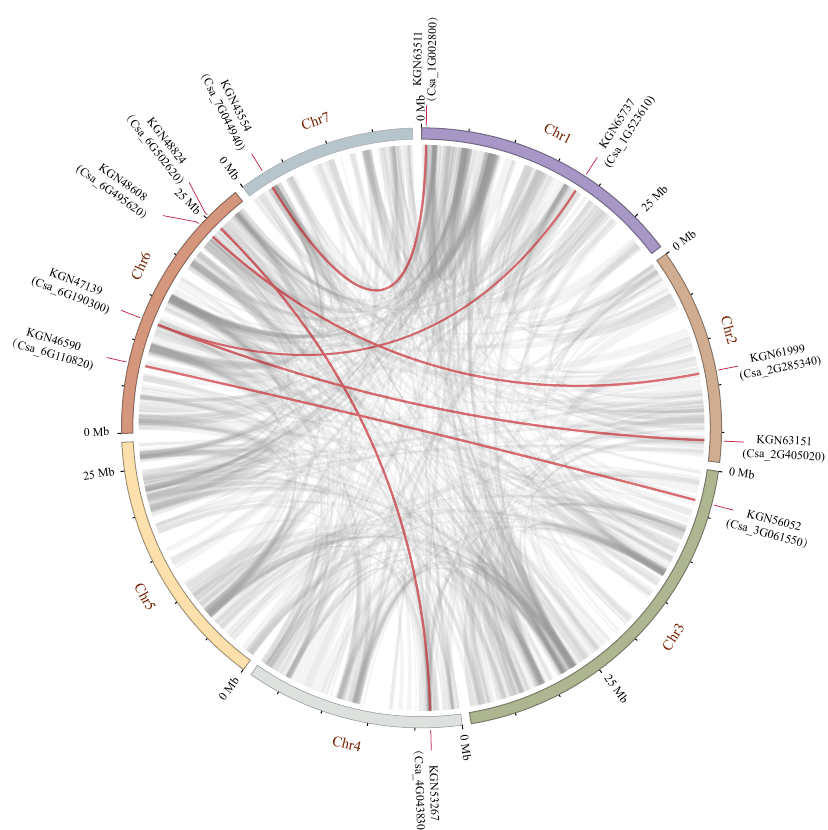
Figure 4. Chromosome localization of CsaGRAS duplicated genes in cucumber. The red lines represent the segmentally duplicated genes and the black bands represent the collinear